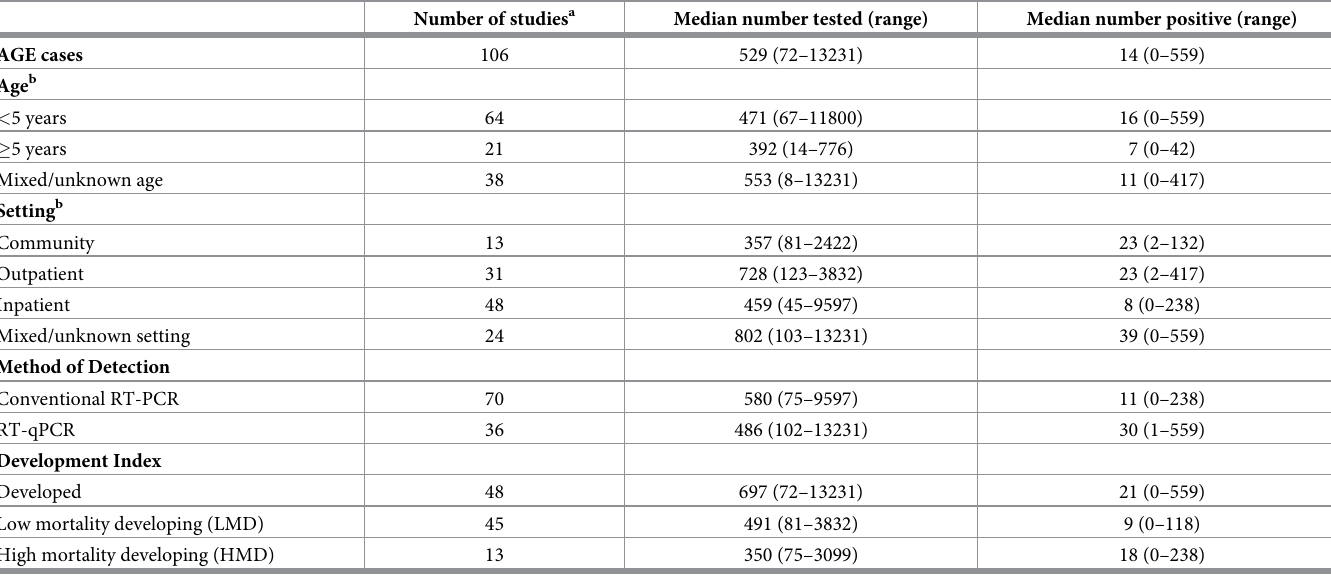
Table 1. Characteristics of studies included in sapovirus